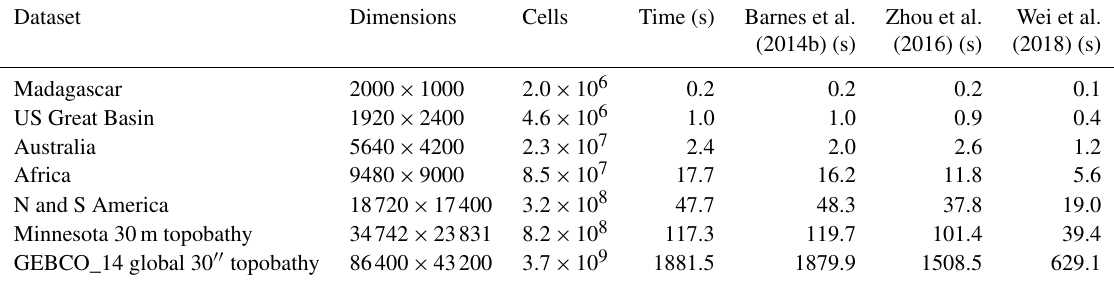
Table 1. Datasets used, their dimensions, and algorithm wall time on the Comet cluster run by XSEDE (see main text for full specifications). Topographic data for Madagascar, the US Great Basin, Australia, Africa, and North and South America were clipped from the global GEBCO_08 30arcsec global combined topographic and bathymetric elevation dataset (GEBCO, 2010). The Minnesota 30m topobathy data are the merged result of two data sources. The topography is resampled from the Minnesota Geospatial Information Office’s 1m lidar elevation dataset (Minnesota Geospatial Information Office, 2019). Bathymetric data were provided by the Minnesota Department of Natural Resources (Minnesota Department of Natural Resources, 2014). Richard Lively of the Minnesota Geological Survey merged and combined these datasets. The GEBCO_14 global 30 (cid:48)(cid:48) topobathy dataset was drawn directly from GEBCO (2014). Wall times are compared against several depression-filling algorithms, as described in the